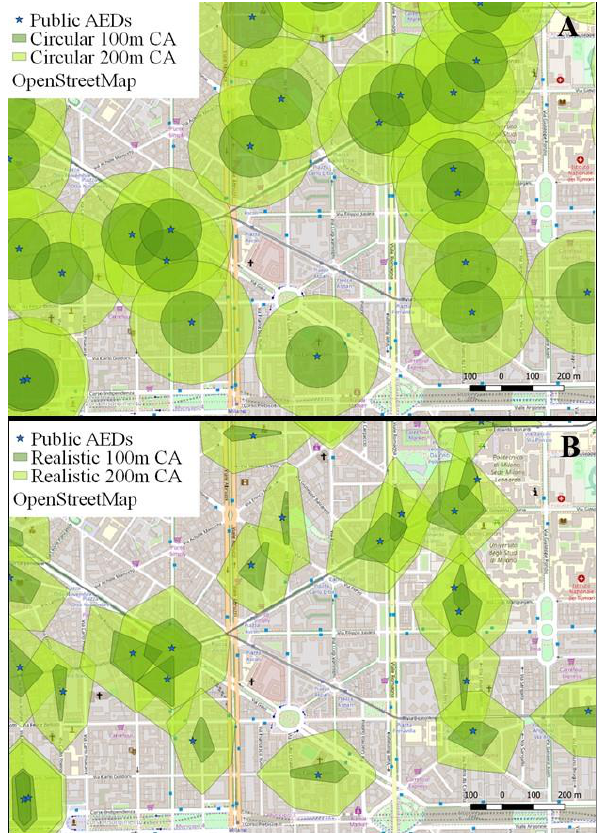
Figure 2. Mapping of circular CAs (panel A) with 100m and 200m radius and of realistic CAs (panel B) with 100m and 200m paths for AEDs in a portion of the city of Milan (Lombardy, Italy).